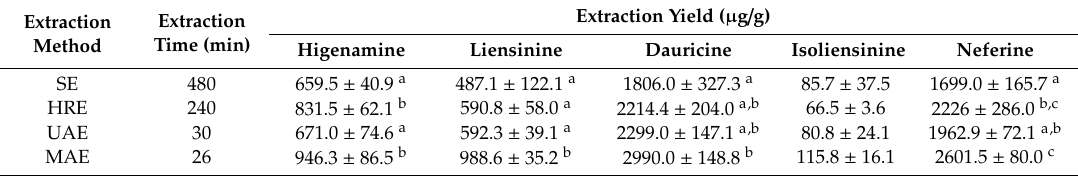
Table 4. Comparison of the results of microwave-assisted extraction with other extraction methods.